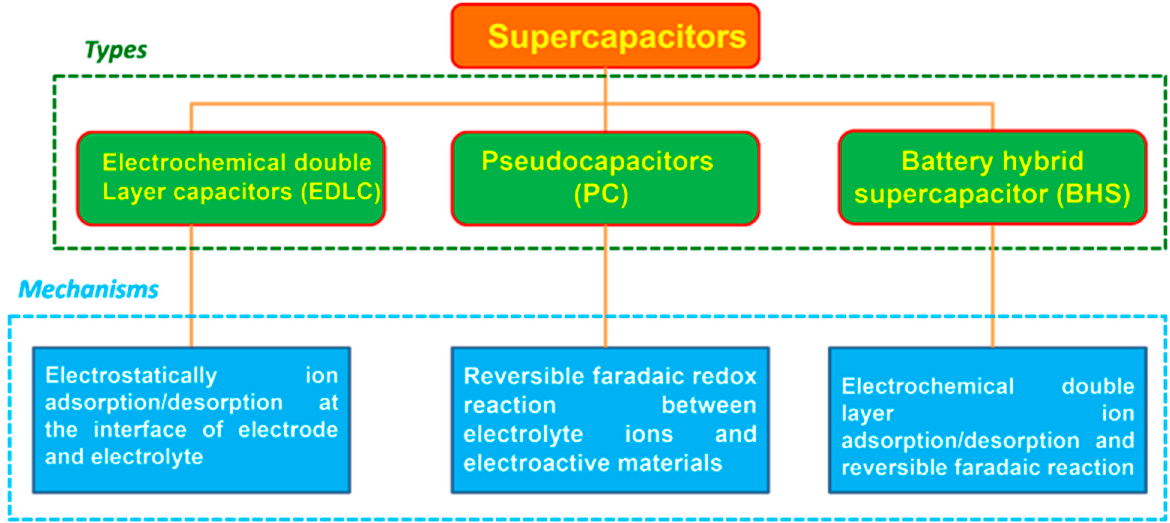
Figure 2. Types of supercapacitors and its